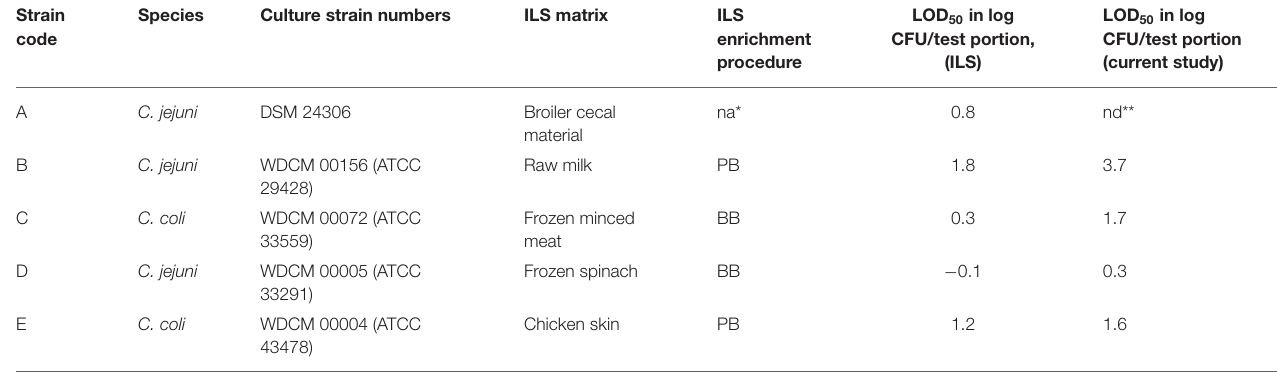
TABLE 1 | Campylobacter reference strains and comparison of log LOD 50 data calculated from the interlaboratory study (ILS) as published in ISO 10272-1:2017 (Biesta-Peters et al., 2019) with data from the current study, using Preston broth (PB) or Bolton broth (BB). Strain Species code